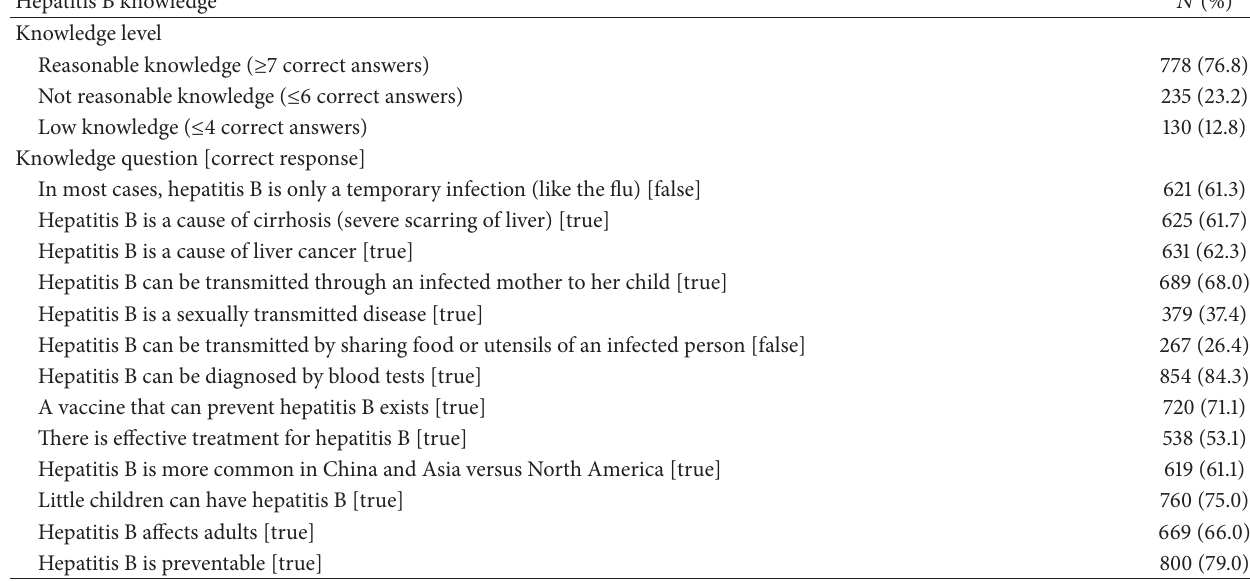
Table 3: HBV knowledge of survey